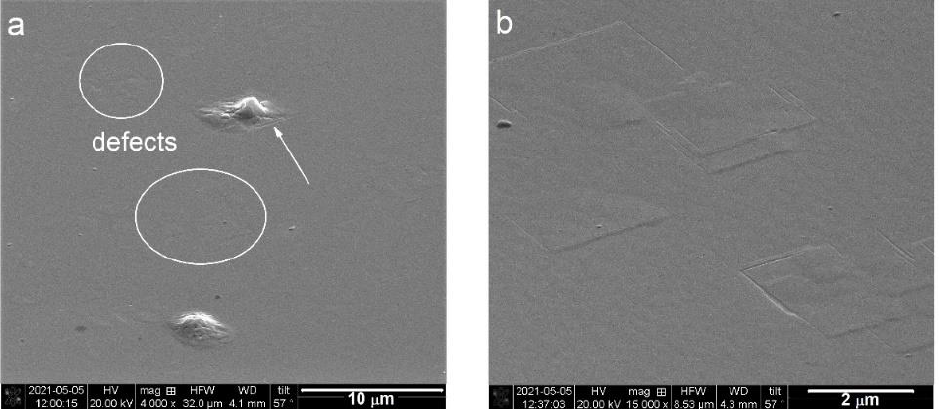
Figure 4. ( a ) SEM image of rectangular-shaped flat defects without (in circles) and with (marked by arrow) precipitates in the center for #SL400; ( b ) A higher magnification SEM image of flat defects.